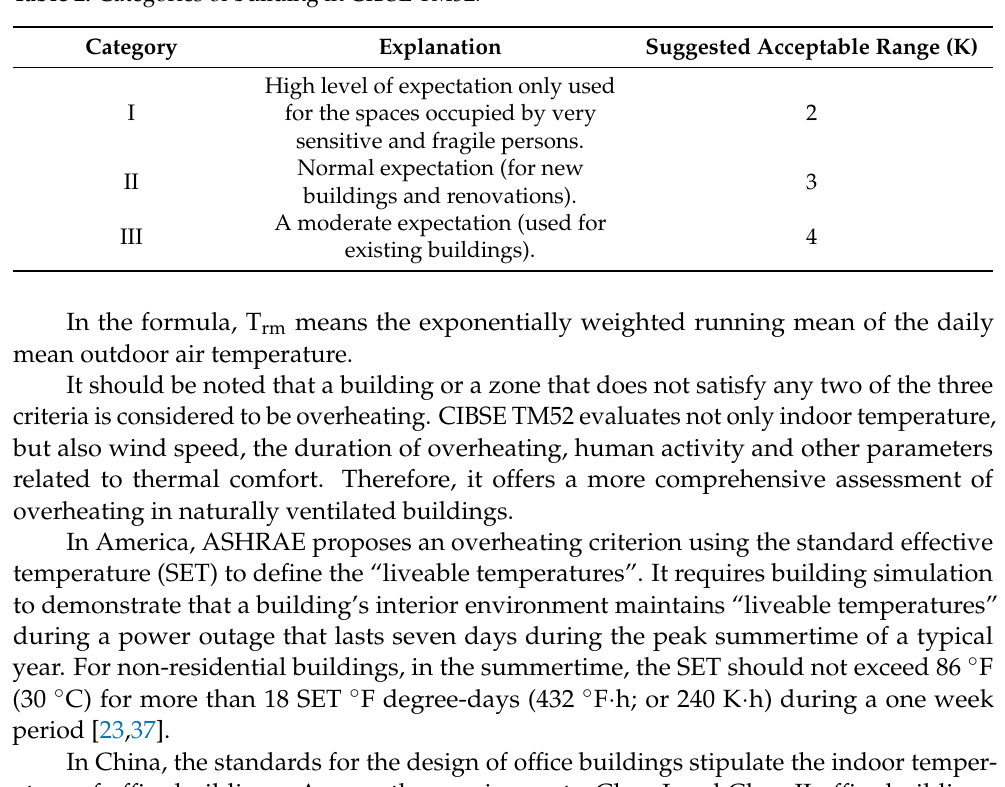
Table 2. Categories of building in CIBSE TM52. Category Explanation Suggested Acceptable Range (K) High level of expectation only used I for the spaces occupied by very sensitive and fragile persons. Normal expectation (for new II buildings and renovations).